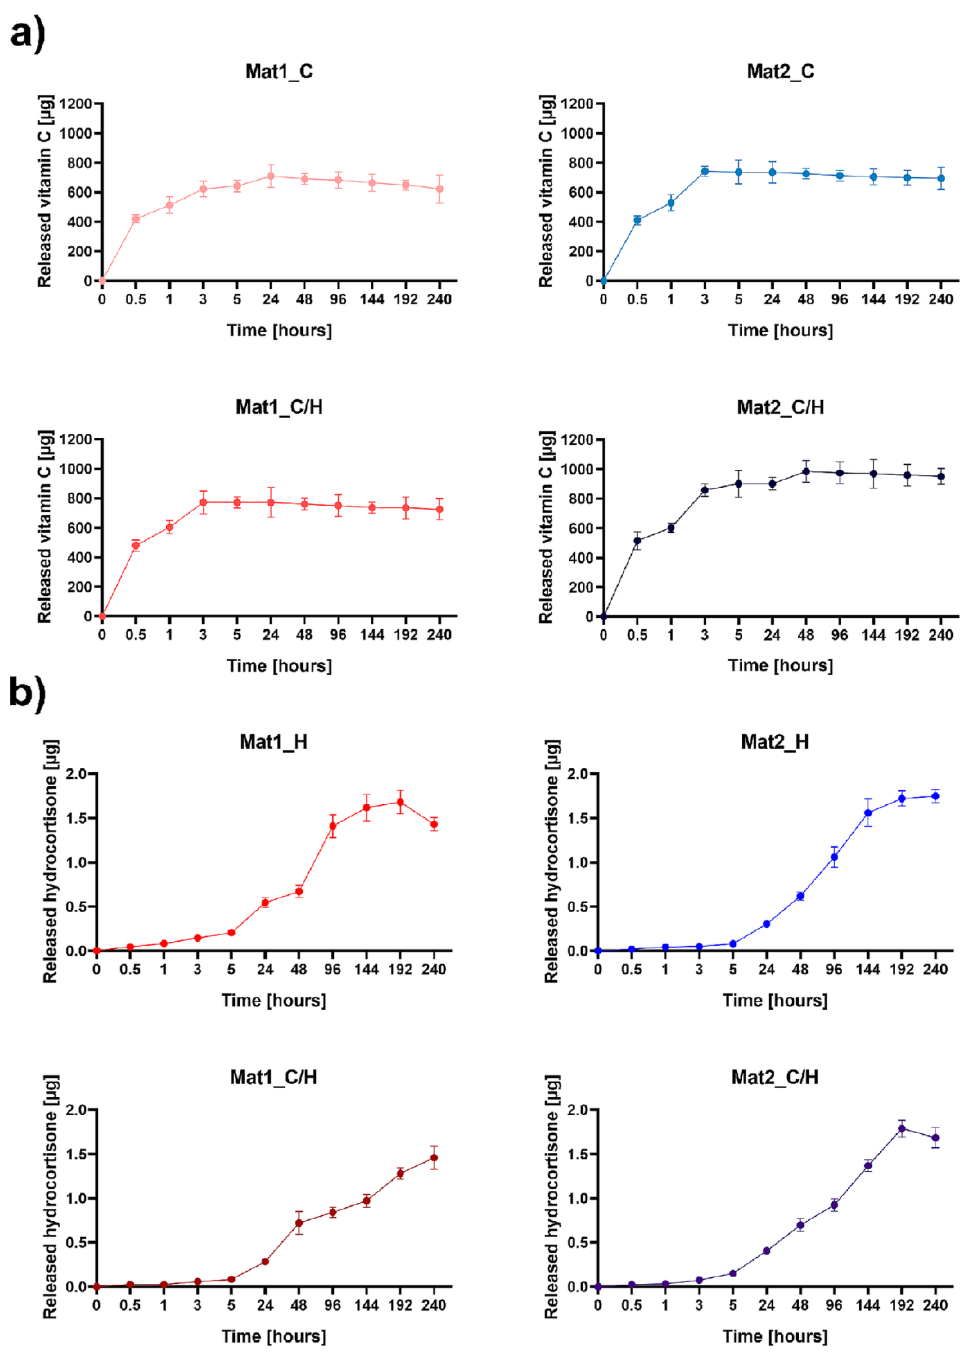
Figure 1. The cumulative release profile of ( a ) vitamin C and ( b ) hydrocortisone from curdlan-based biomaterials (Mat1: curdlan/agarose biomaterial, Mat2: curdlan/chitosan biomaterial, C–vitamin C, H–hydrocortisone, C/H–mixture of vitamin C and hydrocortisone).